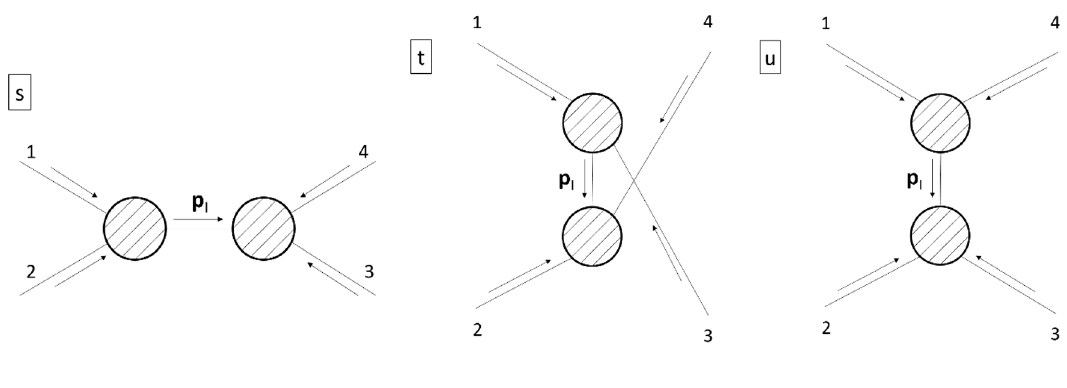
Figure 3. s , t and u -channel exchange diagrams,